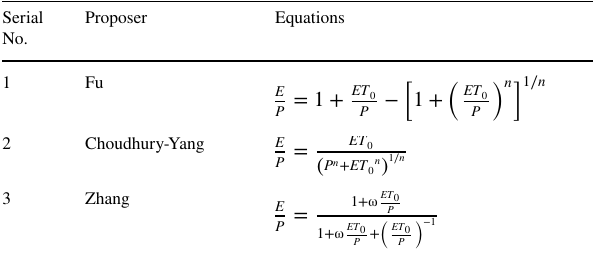
n represents the underlying surface parameters of the basin, which is mainly related to the underlying surface characteristics such as ter- rain, soil and vegetation characteristics; ω indicates the plant-availa- ble water efficiency, which is mainly related to the vegetation charac- teristics of the underlying surface